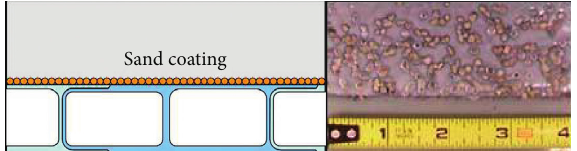
Figure 17: Overview sand coating connection